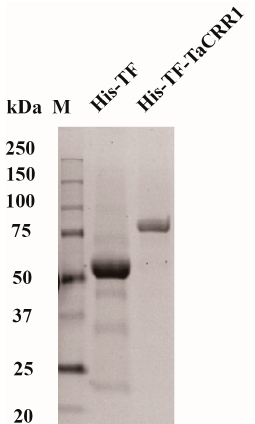
Figure 4. Heterologously-expressed TaCRR1 in Escherichia coli . Sodium dodecyl sulphate- polyacrylamide gel electrophoresis (SDS-PAGE) patterns of the purified His-TF and His-TF-TaCRR1 fusion proteins. His-TF is the control sample.